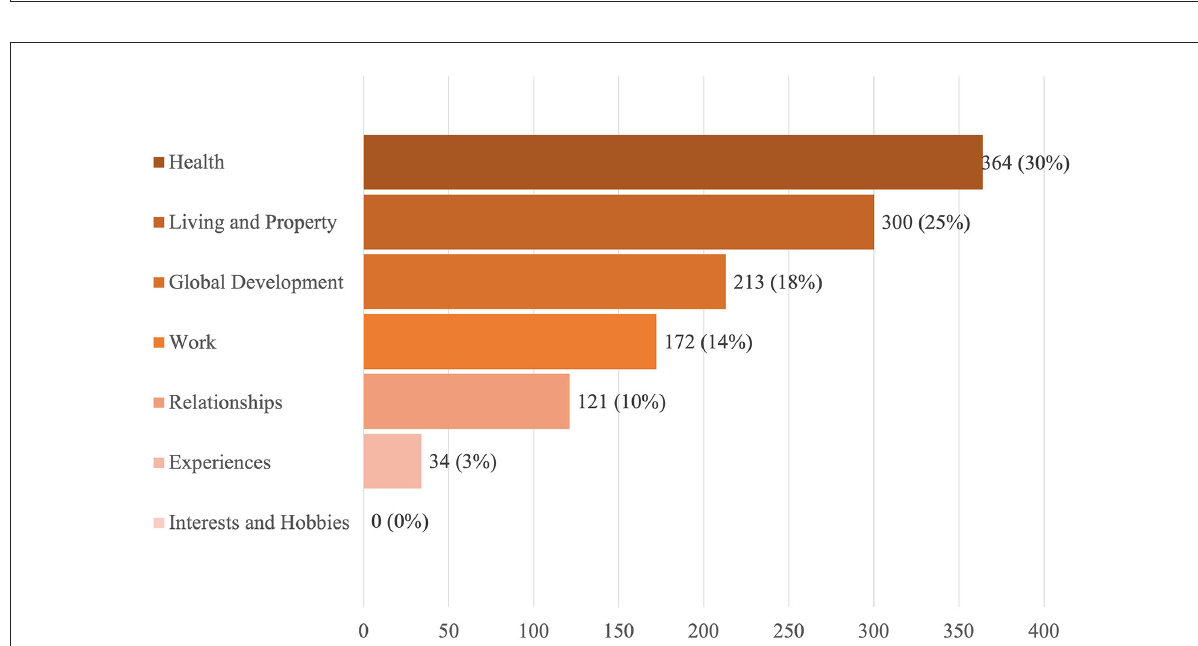
FIGURE2 What do you wish less of in life: Number of mentions and percentages in each category.